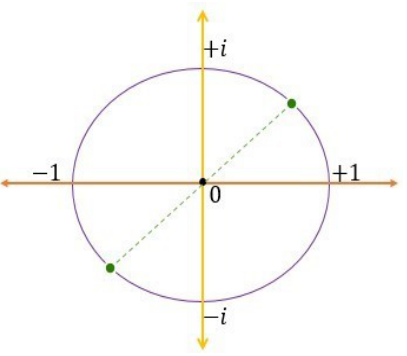
Figure 3. Geometrical representation of complex values .